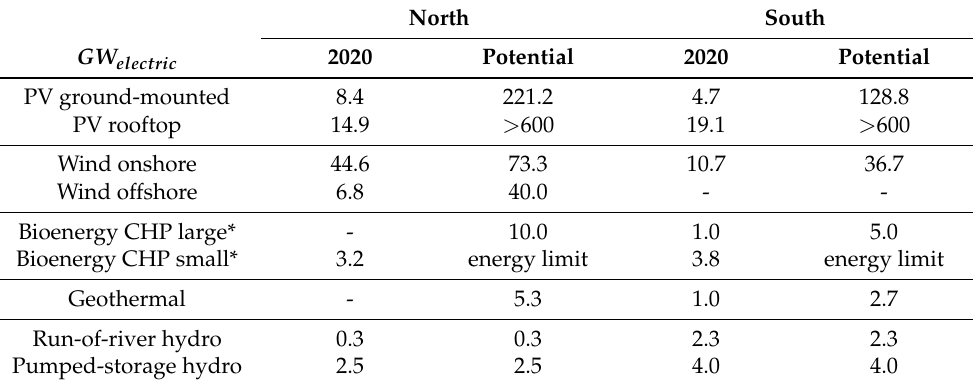
Table 1. Installed RE generation capacities in 2020 and potentials in GW electric in northern and southern Germany. The potential of bioenergy usable in combined heat and power stations (CHP) is limited* by their primary energy potential of 200 TWh in northern Germany and 160 TWh in southern Germany. PV building potential based on Fath [33]. All other data are taken from the 2020 scenario framework [32]. North